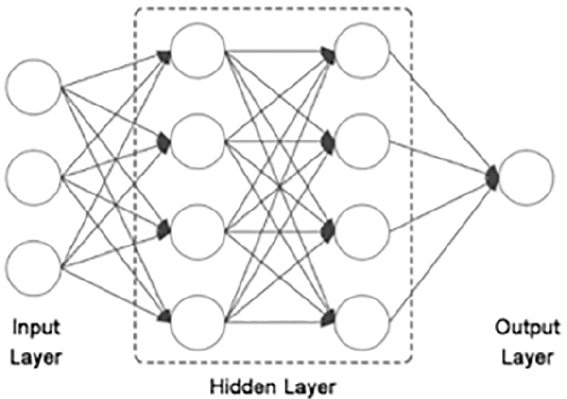
Figure 7. The basic structure of neural networks.